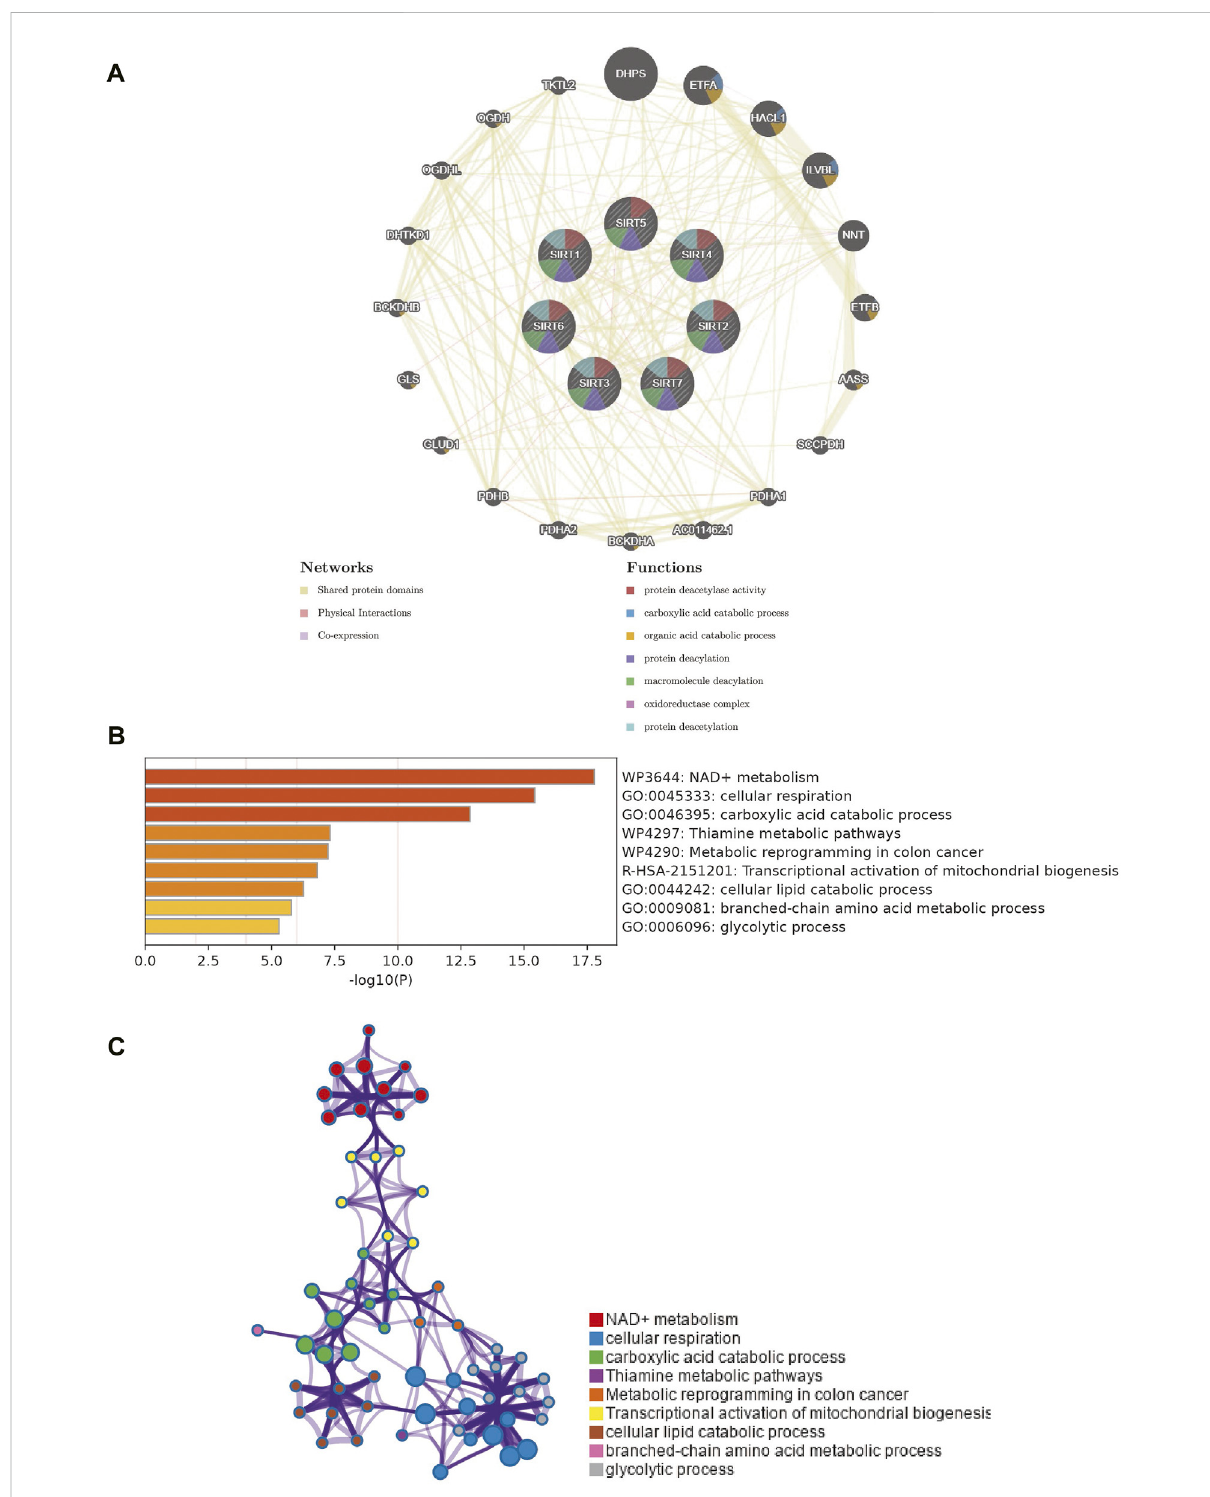
FIGURE 4 PPI network of SIRT family members and enrichment analysis of network genes. (A) PPI network of SIRT family members and their interacting proteins. (B) Gene enrichment in the PPI network as analyzed using Metascape. (C) Network diagram of enrichment analysis results (* p < 0.05, ** p < 0.01, *** p < 0.001, ns: p >